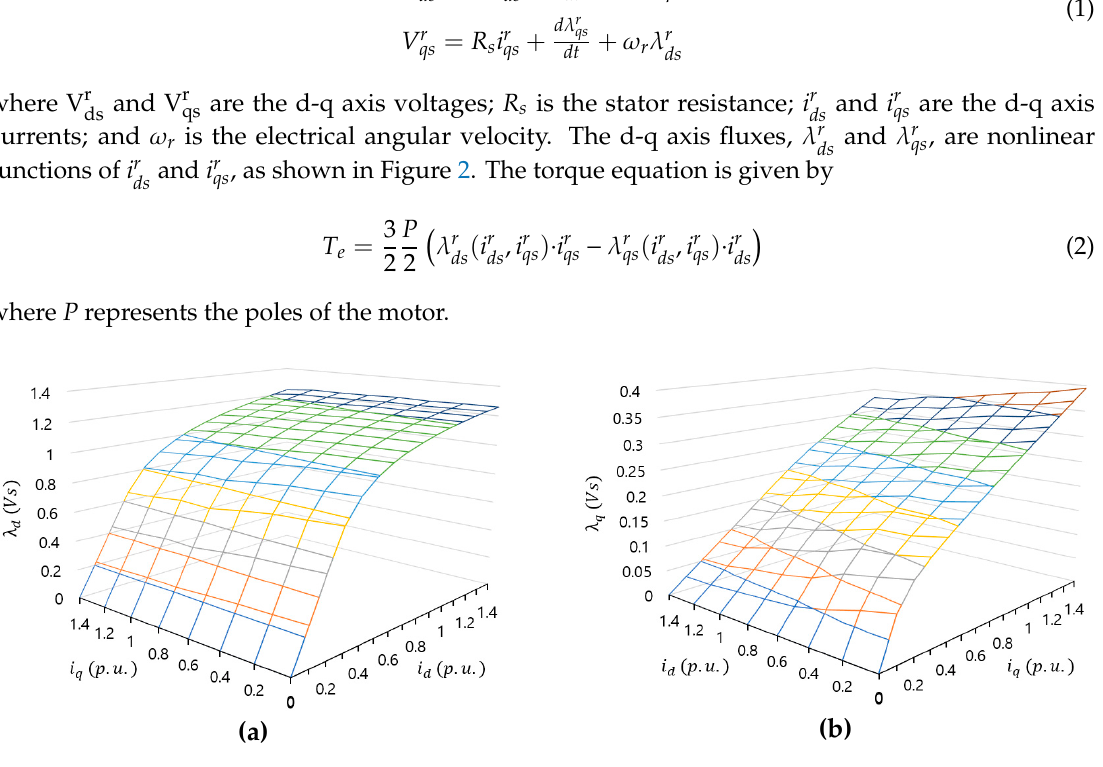
Figure 2. Flux linkages as functions of the currents including cross-coupling: ( a ) λ d and ( b ) λ q .